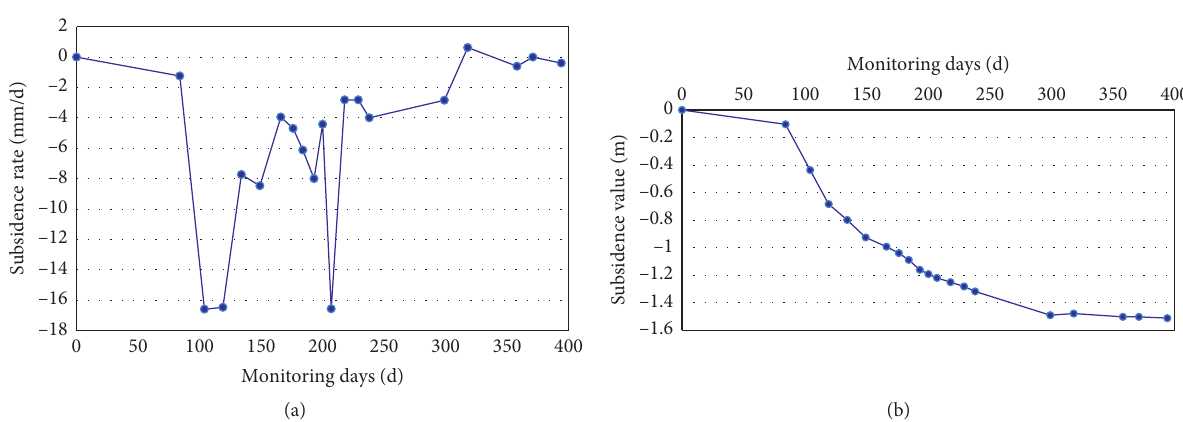
Figure 11: Subsidence data of point A43. (a) The subsidence rate of point A43. (b) The subsidence value of point